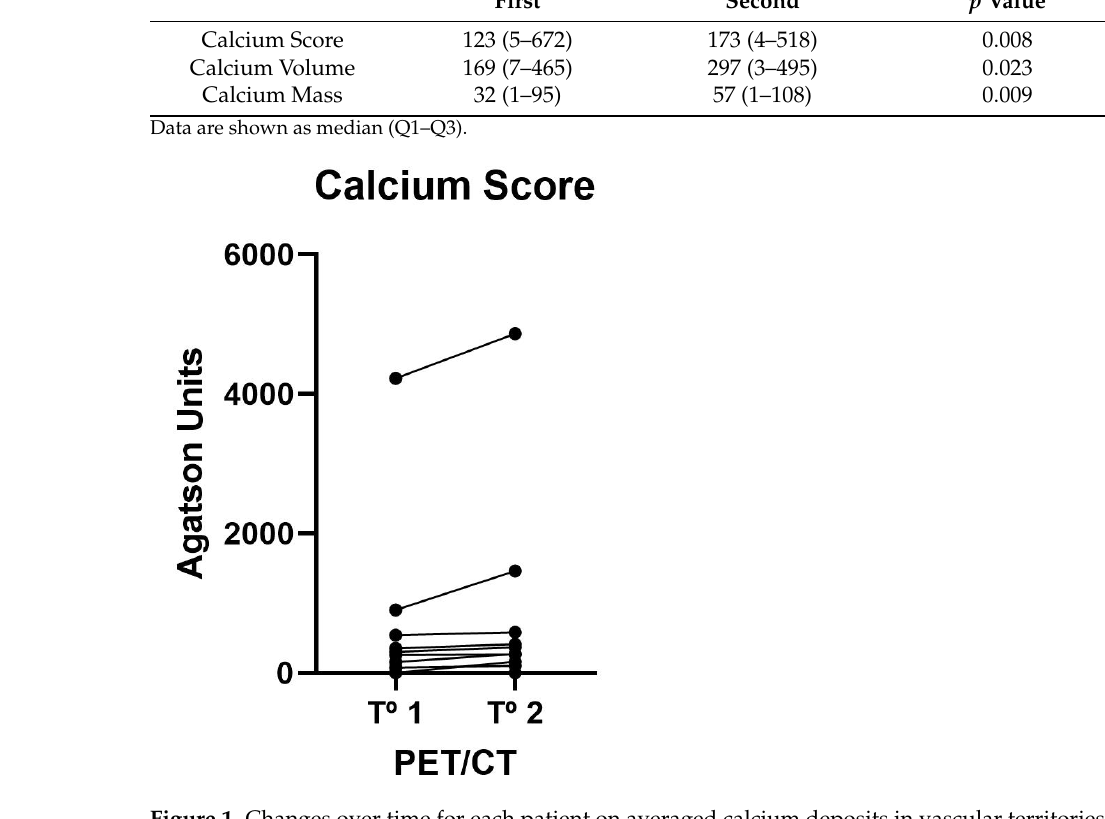
Figure 1. C hanges over time for each patient on averaged calcium deposits in vascular territories of both sides (carotids, ascending, arch, descending and abdominal aorta, iliac, femoral, and popliteal).